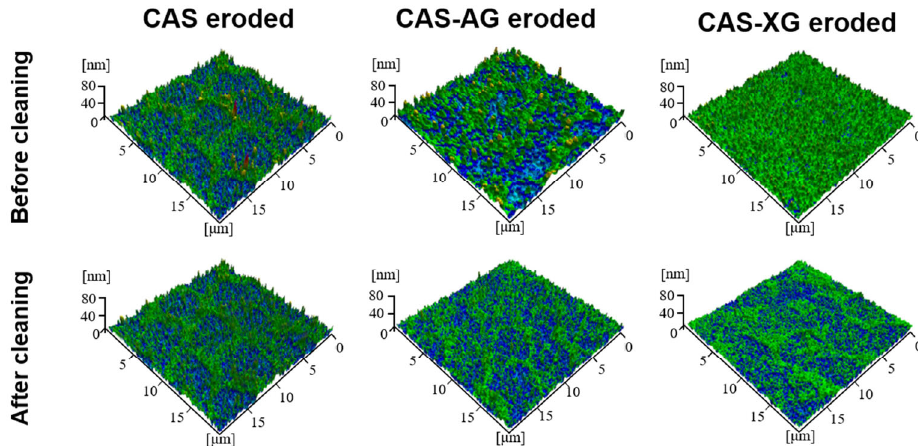
Fig. 1 3D AFM micrographs of three eroded enamel surfaces before and after water wash.